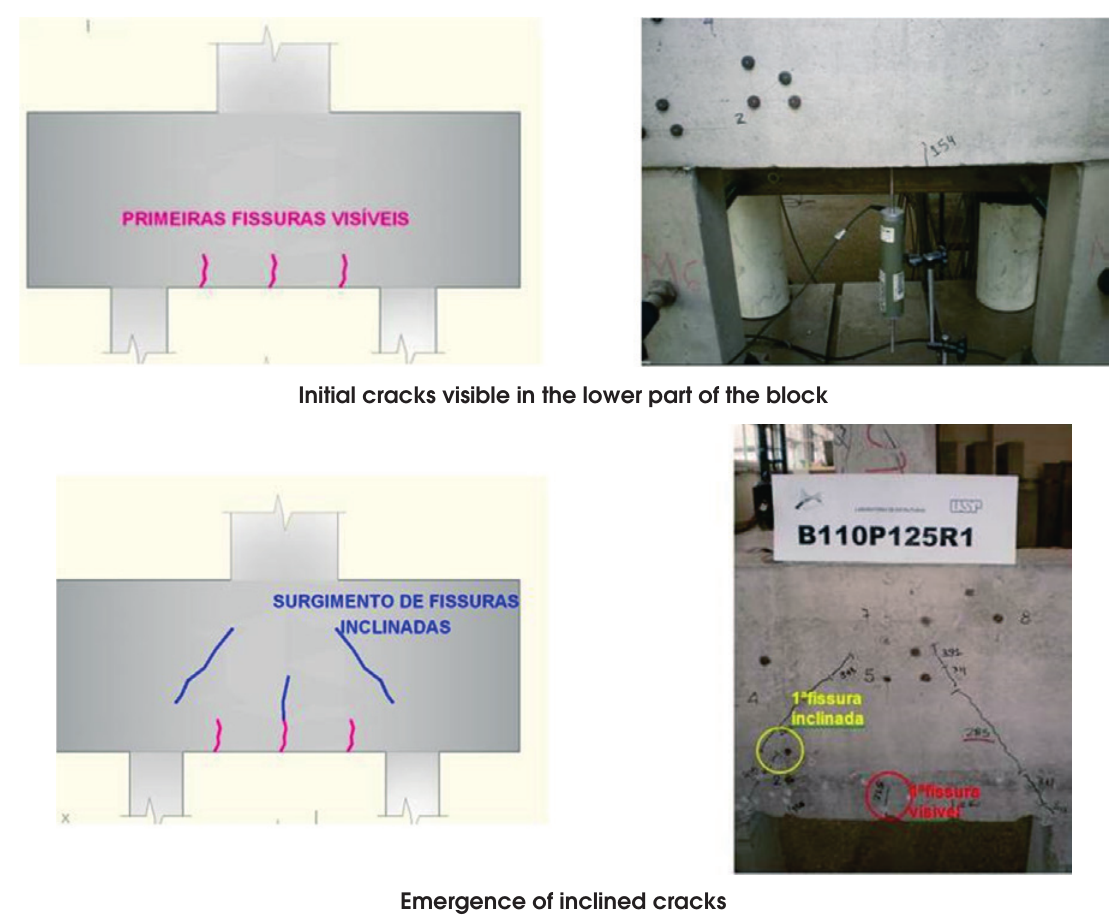
Evolution of cracks in models of two pile caps